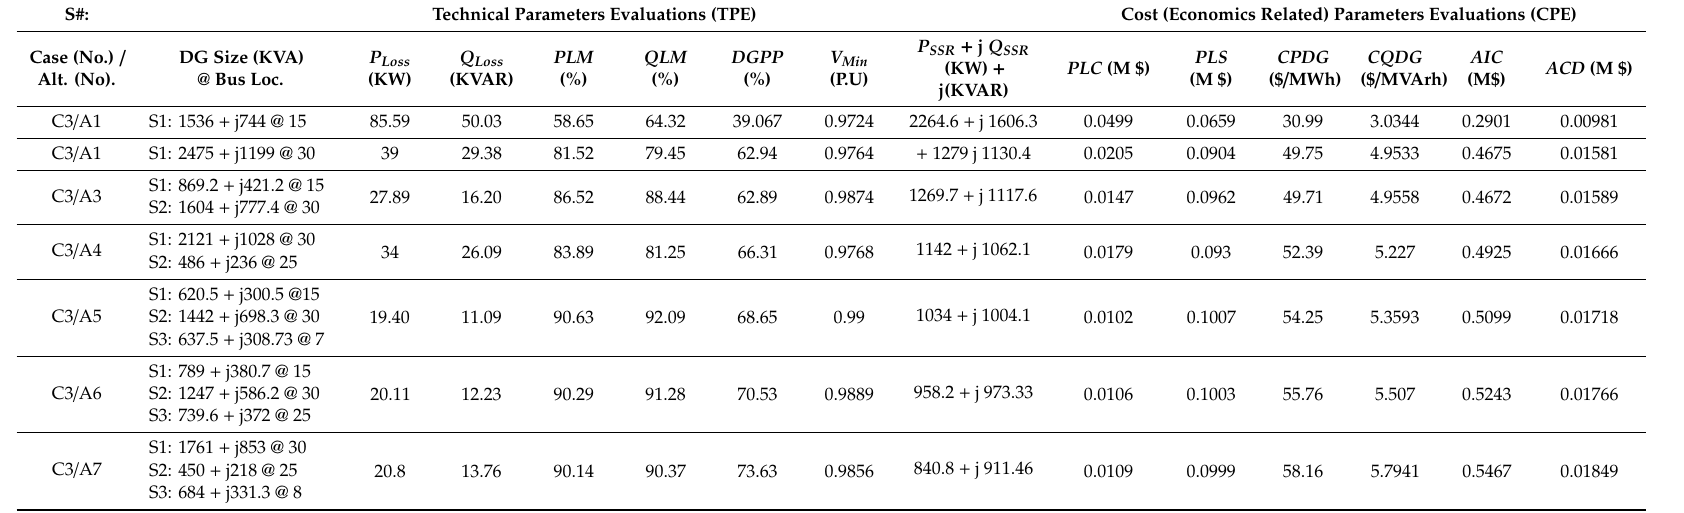
Table 9. Techno-economic evaluation analysis in case 3 (C3_NL) for 33-bus